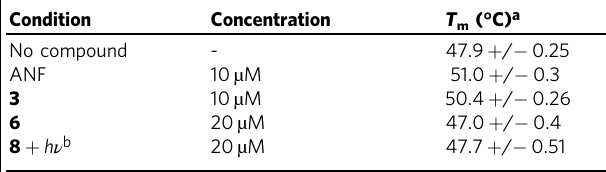
Table 3 T m values for recombinant CYP1B1 + / −